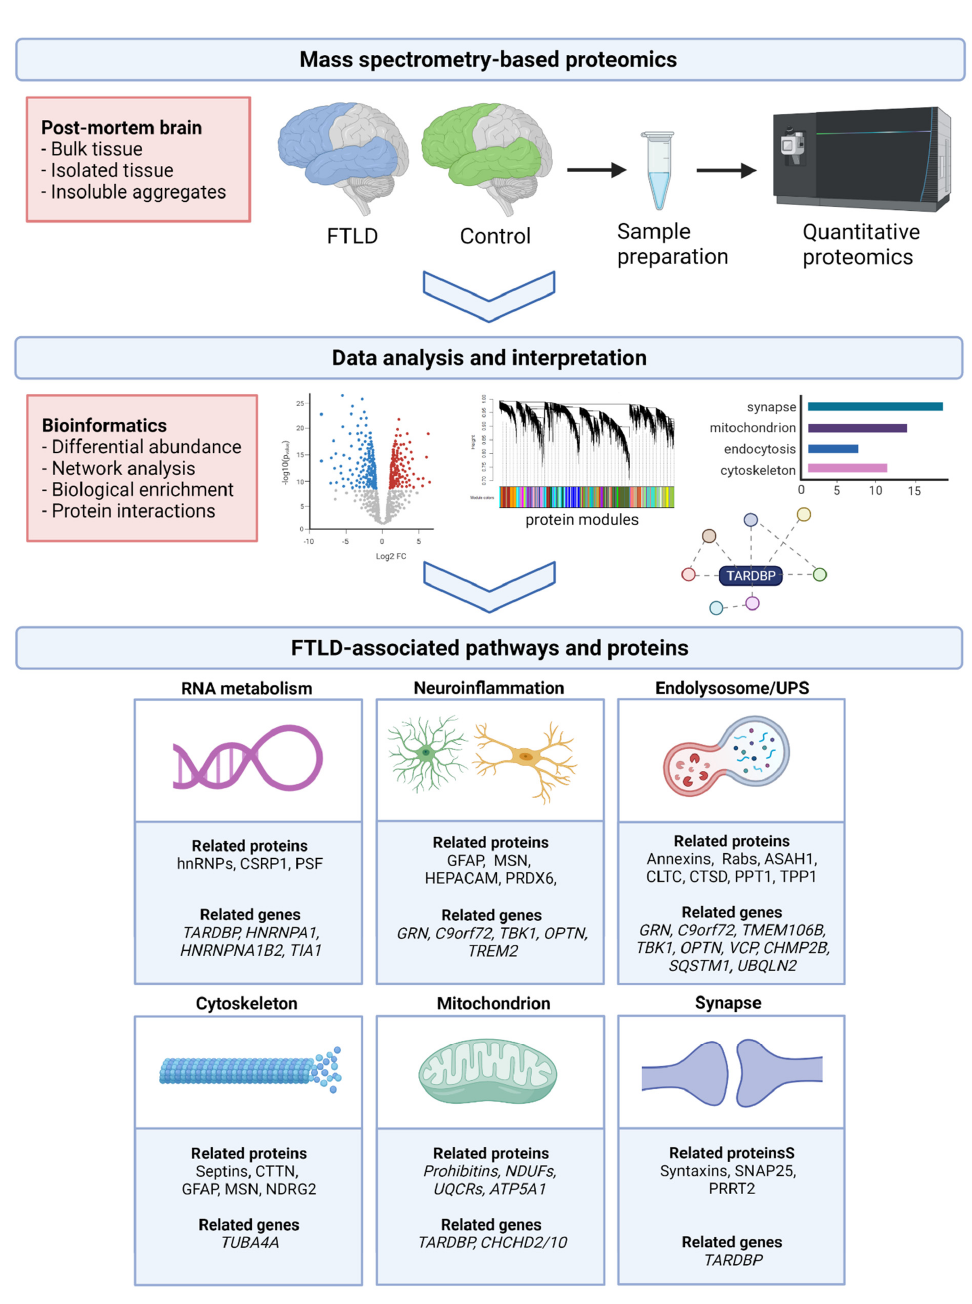
Figure 1. Unbiased proteomics to characterize the proteomic signature of FTLD-TDP. Following brain tissue preparation, several techniques are currently available to quantify the proteomic data generated by mass spectrometry. Different bioinformatics approaches can be applied to analyze the differentially expressed proteome; i.e., to organize these proteins in biologically meaningful groups (modules), to evaluate the protein-protein interactions, or to assess enrichment for specific biological pathways, cell types, and/or genetic risk factors. By reviewing the various proteomic studies performed in FTLD-TDP, six core pathways could be identified that are implicated in the disease pathogenesis. For each pathway, we mention several central proteins/protein families, which were either detected by multiple studies or validated by individual studies (see also Tables 2 and S1). In addition, the major FTLD genes associated with these pathways are listed, as derived from literature. Importantly, both lists should be regarded as examples and are not exhaustive. Created with BioRender.com